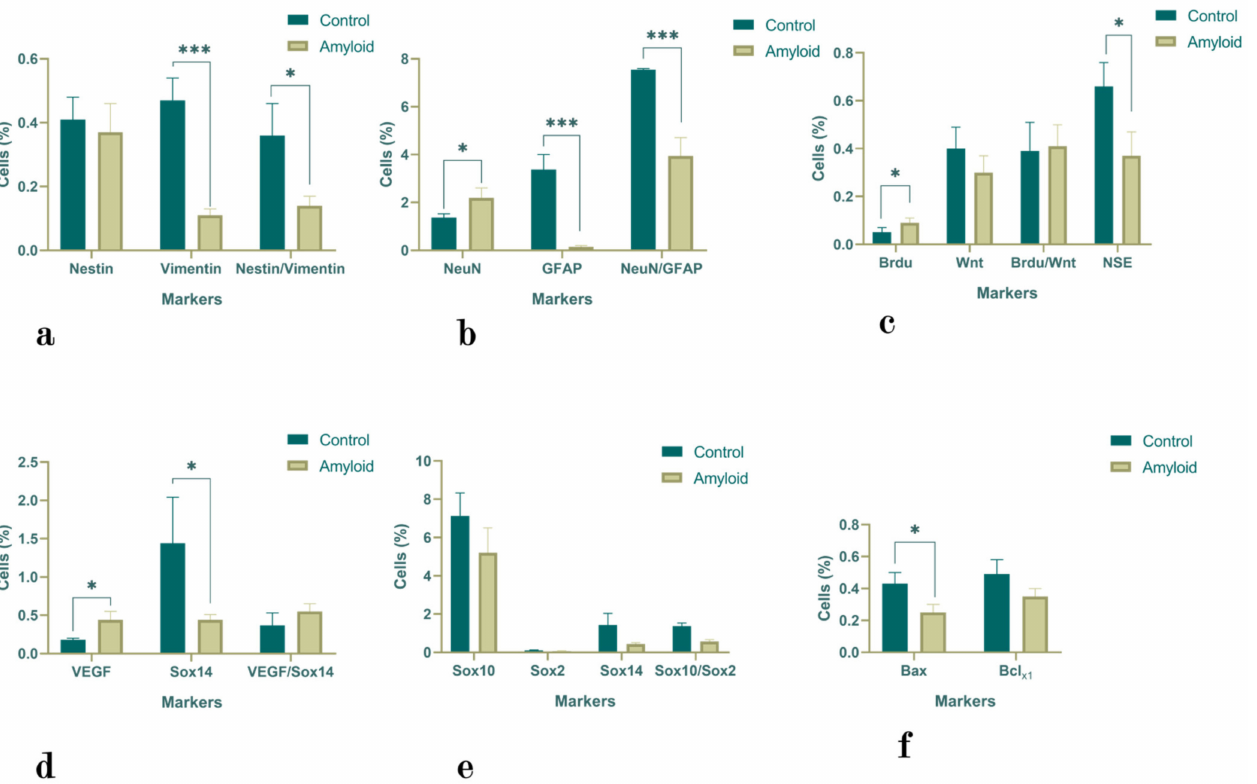
Figure 1. The proportion of Nestin-, Vimentin-, and Nestin/Vimentin- ( a ); NeuN-, GFAP-, and NeuN/GFAP- ( b ); NSE-, BrdU-, Wnt-, and BrdU/Wnt- ( c ); VEGF-, Sox14-, and VEGF/Sox14- ( d ); Sox10-, Sox2-, Sox14-, and Sox10/Sox2- ( e ); and Bax-and Bcl-xL-positive ( f ) cells in the hippocampus under normal conditions and under the influence of A β (1-42). Statistical significance is indicated as follows: *** p < 0.0001 and * p <